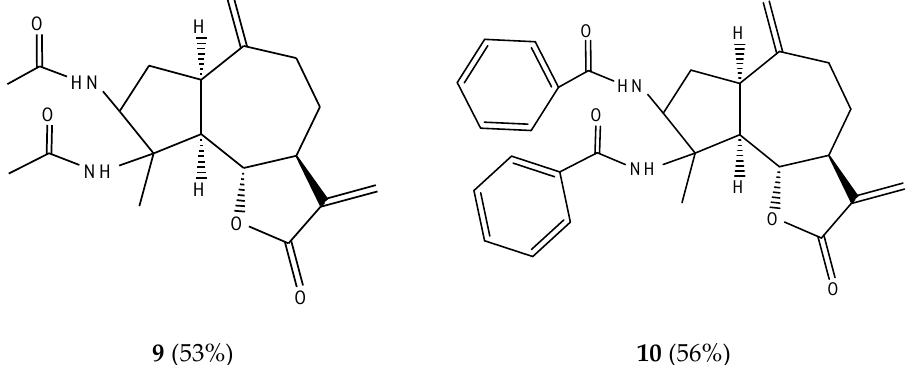
Figure 2. Structures of amino derivatives of estafiatin 9, 10.